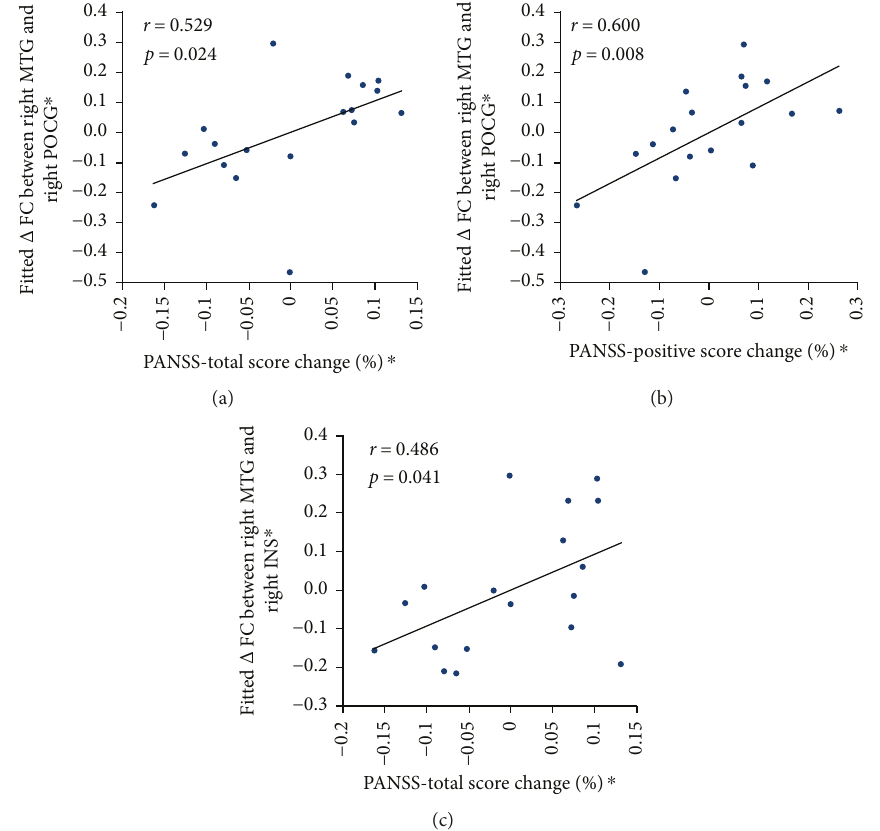
Figure 4: The relationship between altered functional connectivity (FC) and patient ’ s scores of PANSS. (a) and (b) denote the signi fi cant correlations between the FC change (right MTG and right postcentral) and the percentage change scores of PANSS-total score (a) and PANSS-positive score (b). (c) denotes the signi fi cant relationship between the FC change (right MTG and right insula) and the percentage change score of PANSS-total score. Δ =week 4 − baseline. ∗ means the residual value after the regression